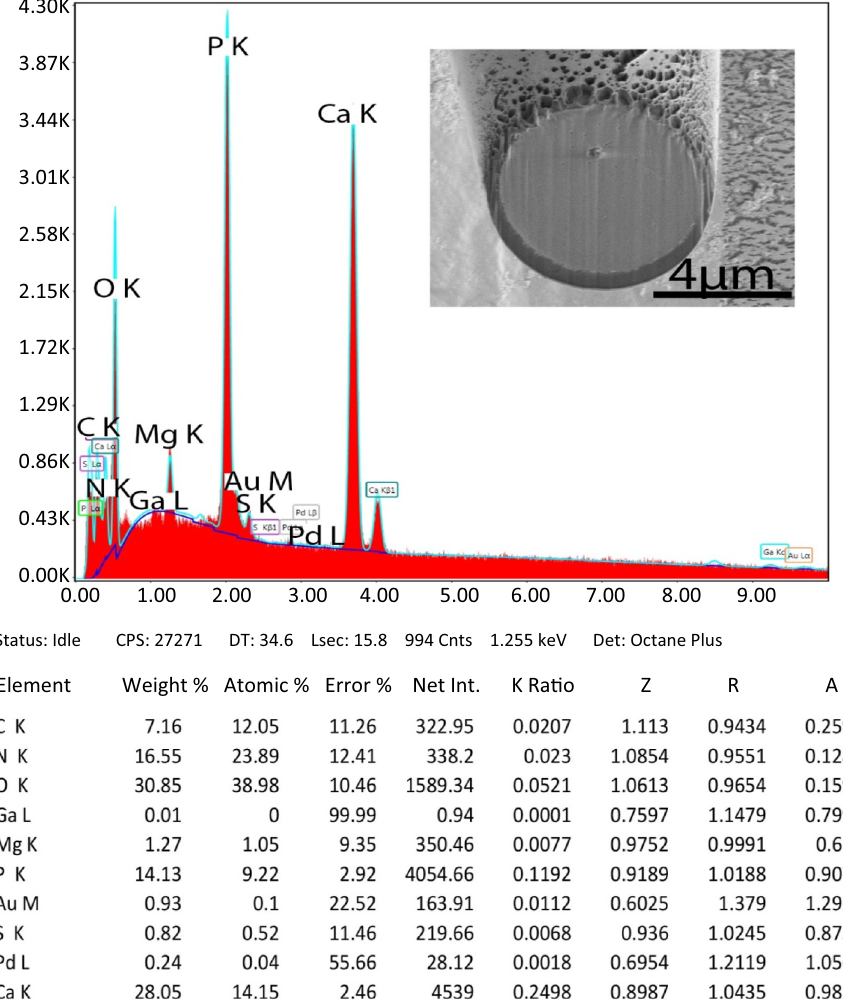
Figure 24. The printout for the elemental scan (EDXA) of a hook near the middle of the proboscis of Neoandracantha peruensis . Note values for all levels of the cut hooks in Table 4. Table 3. Distribution and size of trunk spines of the foretrunk of 3male and 3female cystacanths of Neoandracantha peruensis . Anterior fi eld of